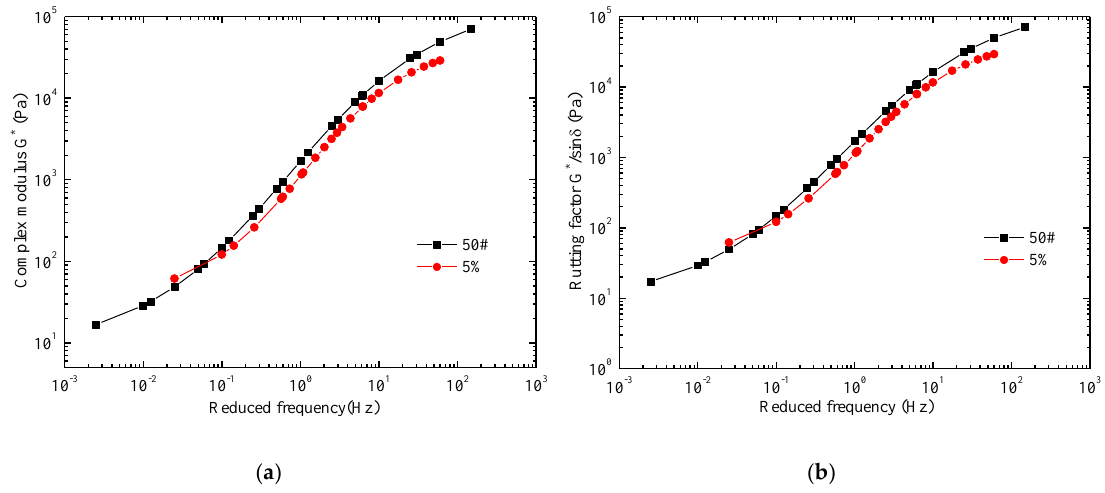
Figure 13. The changes of different parameters with reduced frequency change for the unaged asphalt. ( a ) Complex modulus; ( b ) Rutting factor .